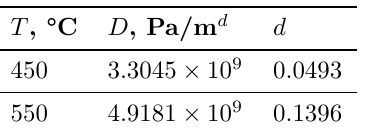
Table 3. Fitted parameters for Eqn. 28. The fitting was done with σ ∗ root in Pa and r in m.